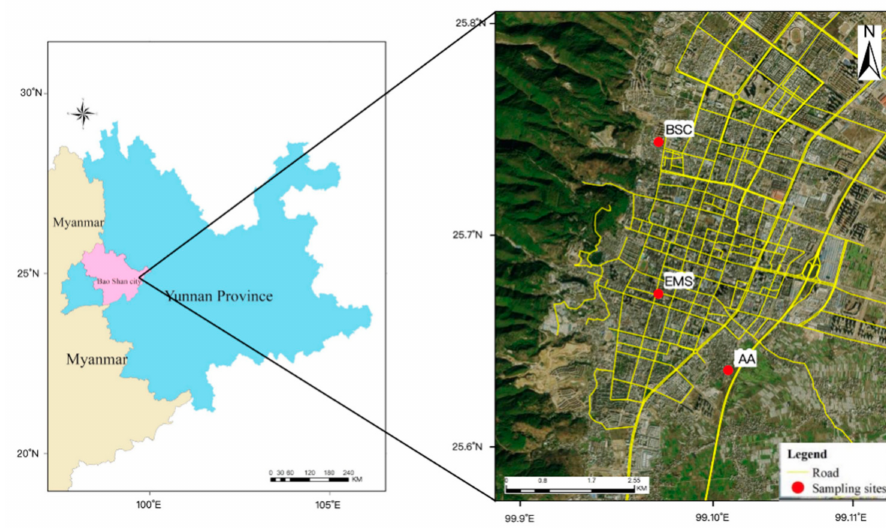
Figure 1. Location of the sampling sites in Baoshan,